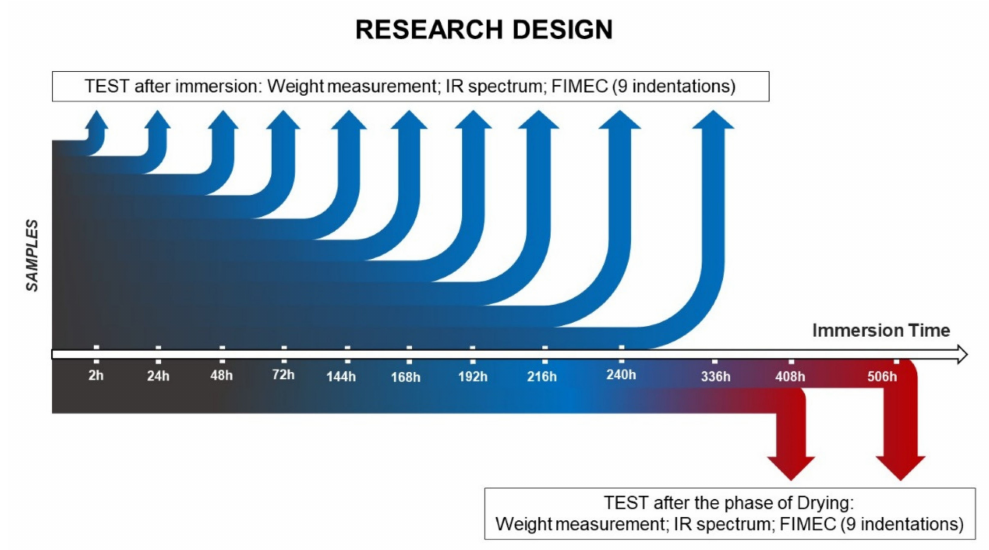
Figure 2. Experimental design.